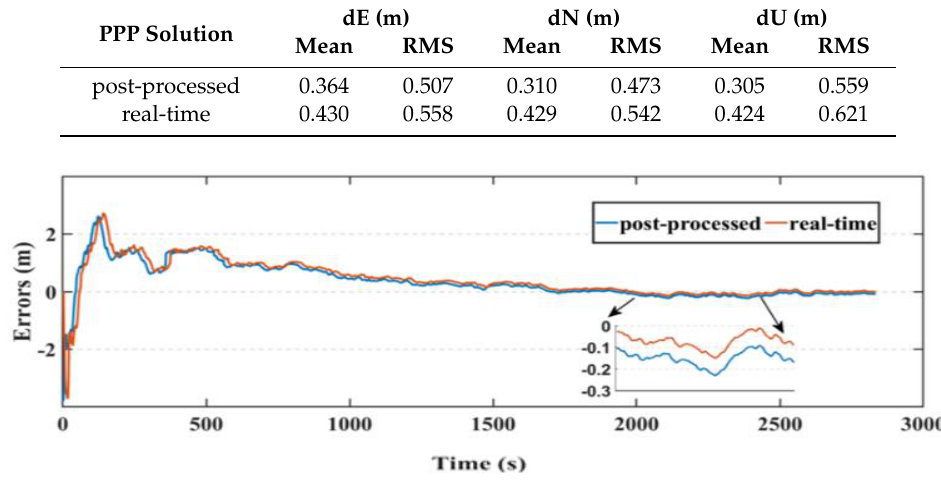
Figure 17. Position errors in East direction (first dataset).